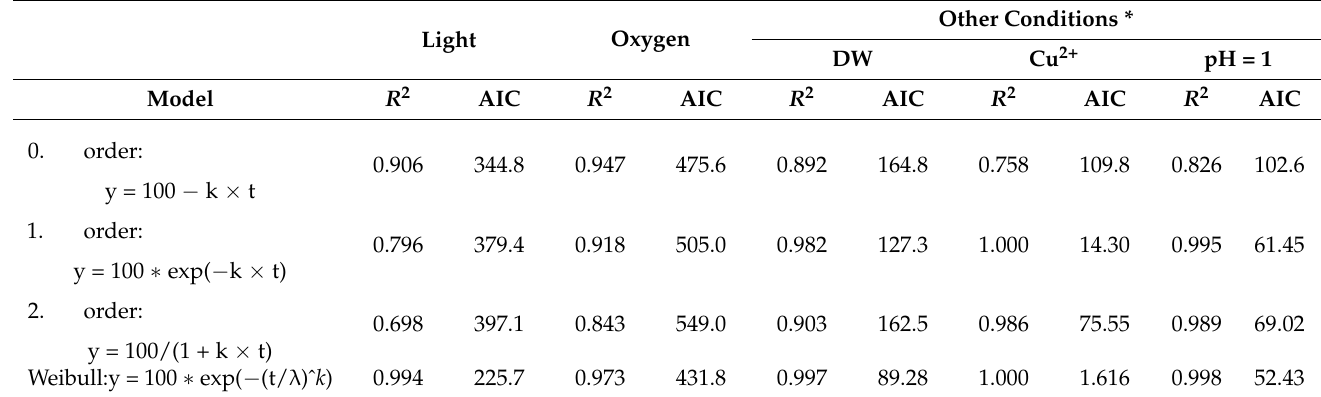
Table 3. Kinetic models for vitamin D3 degradation under different conditions. Light